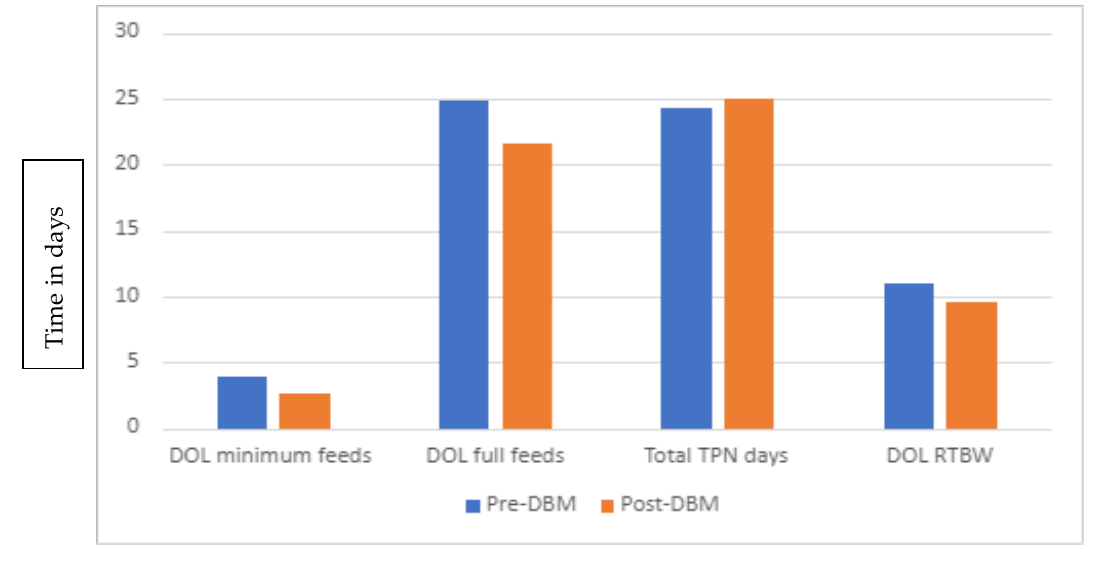
Figure 1. Comparison of enteral, parenteral feeds and return to birth weight (RTBW) between the two infant cohorts.